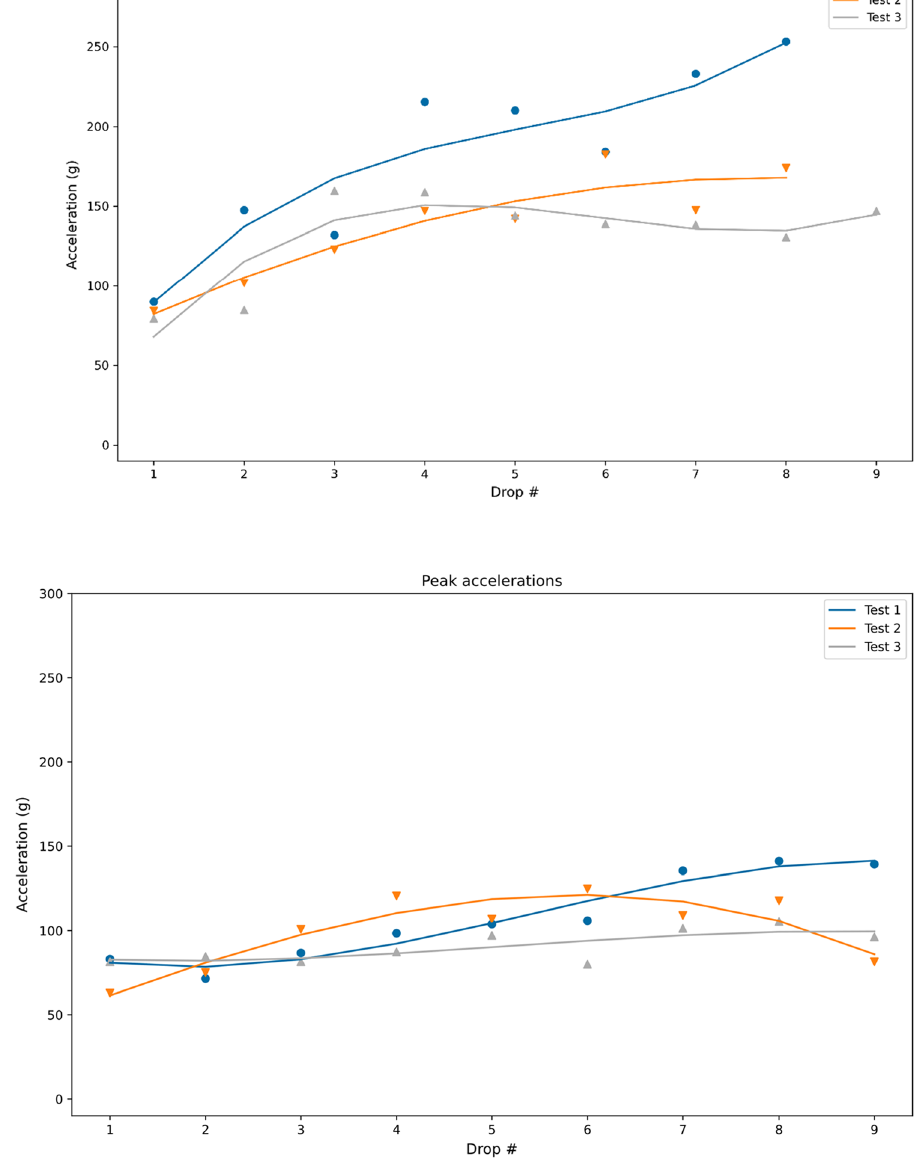
Fig. 9 Peak accelerations for three different drop sequences with P2 (495 g / 200 × 100 × 43 mm / 3–3-3 wrapping pattern)